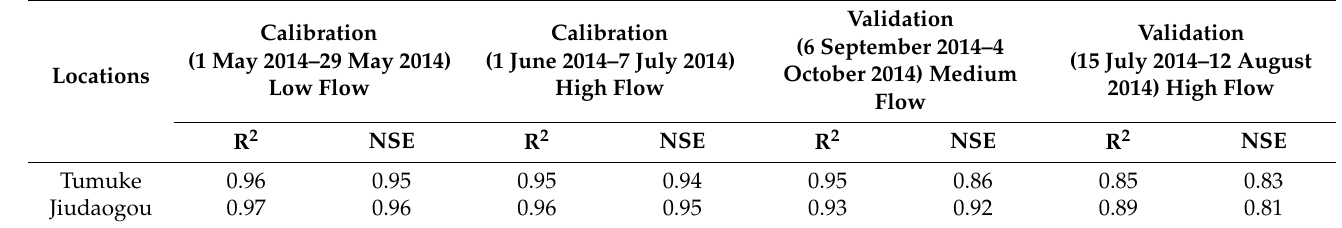
Table 3. The evaluation indicators of MIKE 21 for water levels within the Zhalong